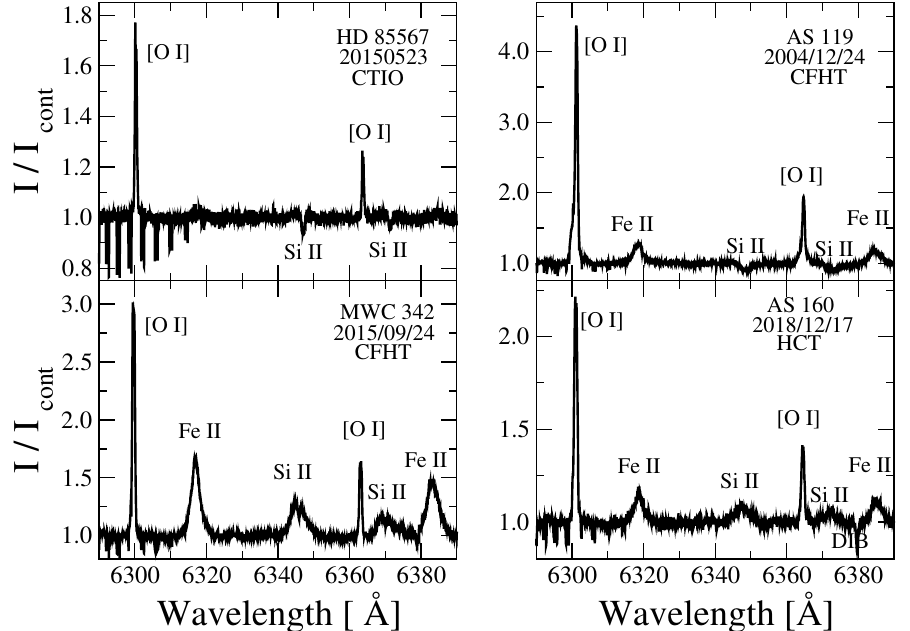
Figure 2. Selection of emission-line profiles around the neutral oxygen forbidden lines of some FSCMa group objects. Objects’ names, observing dates, and the observatory ID are shown in each panel. Intensity is normalized to the local continuum, and heliocentric wavelength scale is shown in Å. Note: The line at 6318 Å has also been identified as that of Mg I [18] or Mg II